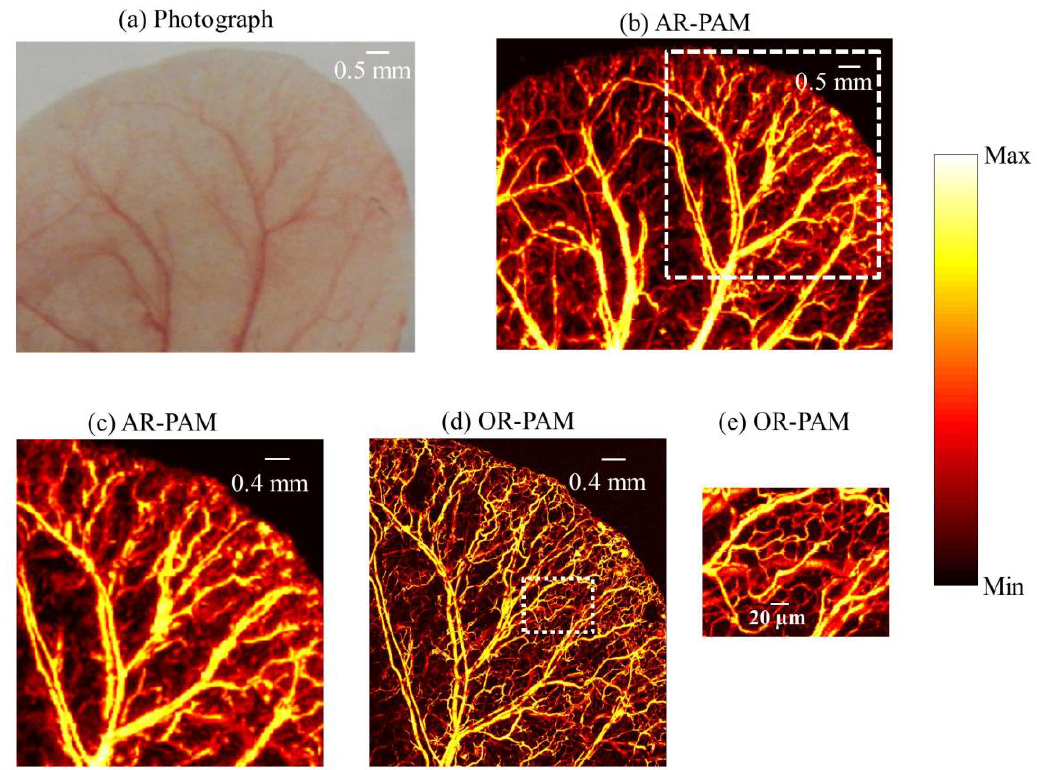
Figure 5. In vivo photoacoustic image of mouse ear: ( a ) photograph of the mouse ear vasculature; ( b ) AR-PAM image; ( c ) close up of the region of interest (ROI) in ( b ) as shown by white dash line; ( d ) OR-PAM image of the same ROI; ( e ) close up of the region of interest in ( d ) as shown by white dotted line.